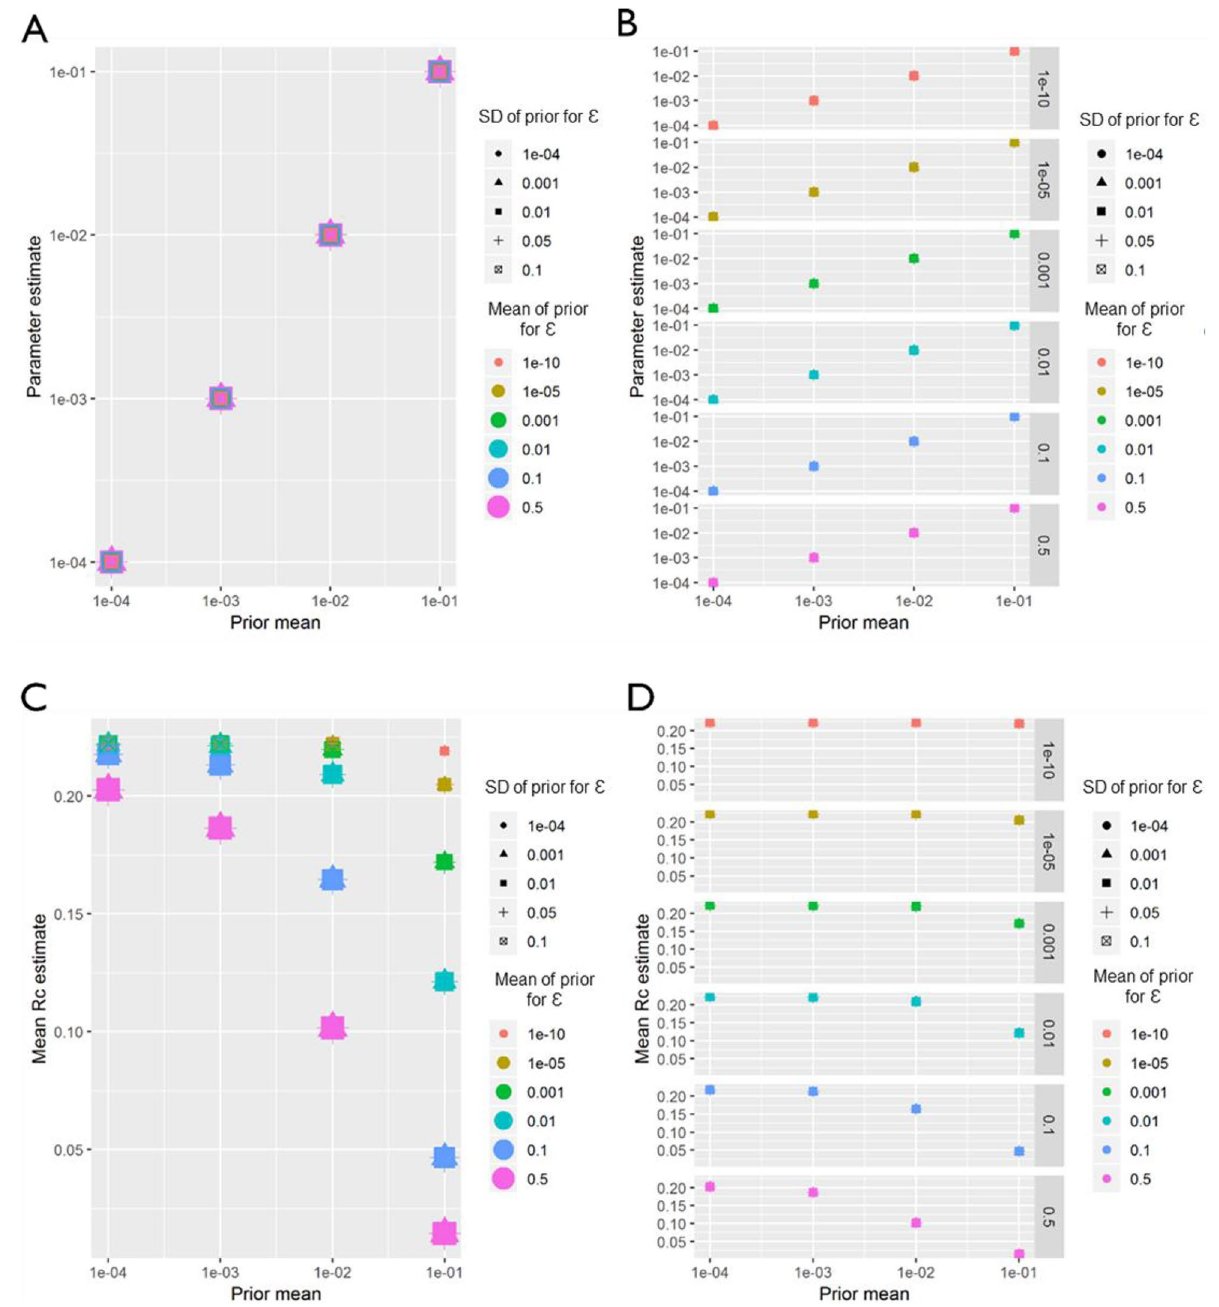
Figure 12. China ( P. vivax ) Sensitivity Analysis. Sensitivity analysis showing the impact of varying the prior means for P. vivax in China. Sensitivity analysis showing the impact of varying the prior means for Eswatini. Sensitivity analysis showing the impact of varying the prior mean for the distance kernel shaping parameter, β. The different colours and shapes represent different means and standard deviations respectively of the normally- distributed prior of epsilon, ε, swhich represents shapes represent different hazards of infection by an external, unobserved source. For ( A )–( D ), the x-axis represents the prior mean used for β. ( A ) the y-axis shows the maximum a posteriori parameter estimate for the parameter β. ( B ) shows the same results, stratified by the prior mean of ε for clarity. ( C ) Shows the impact of priors for β and ε on the mean Rc estimate, and again ( D ) shows the same result, stratified by the prior mean of